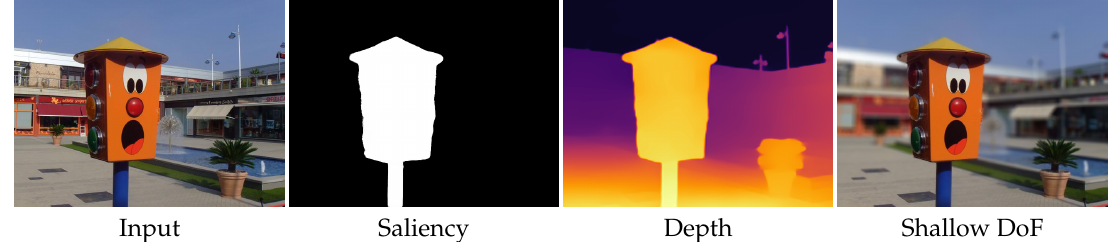
Figure 1. Shallow depth-of-field (DoF) rendering from an arbitrarily captured